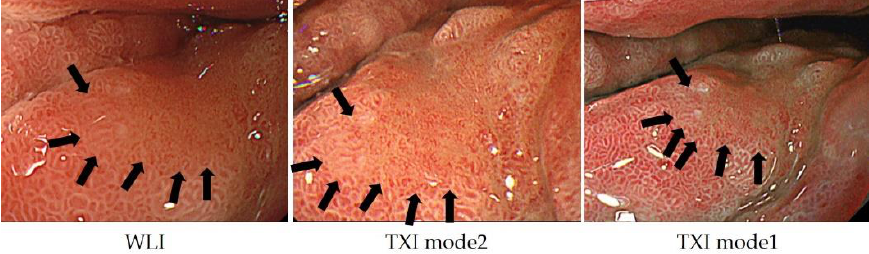
Figure 10. In TXI mode2, the structure is enhanced compared to WLI, and the relatively dark areas in the back are adjusted to be brighter; in TXI mode 1, the color tone is further enhanced and the contrast is more distinct.